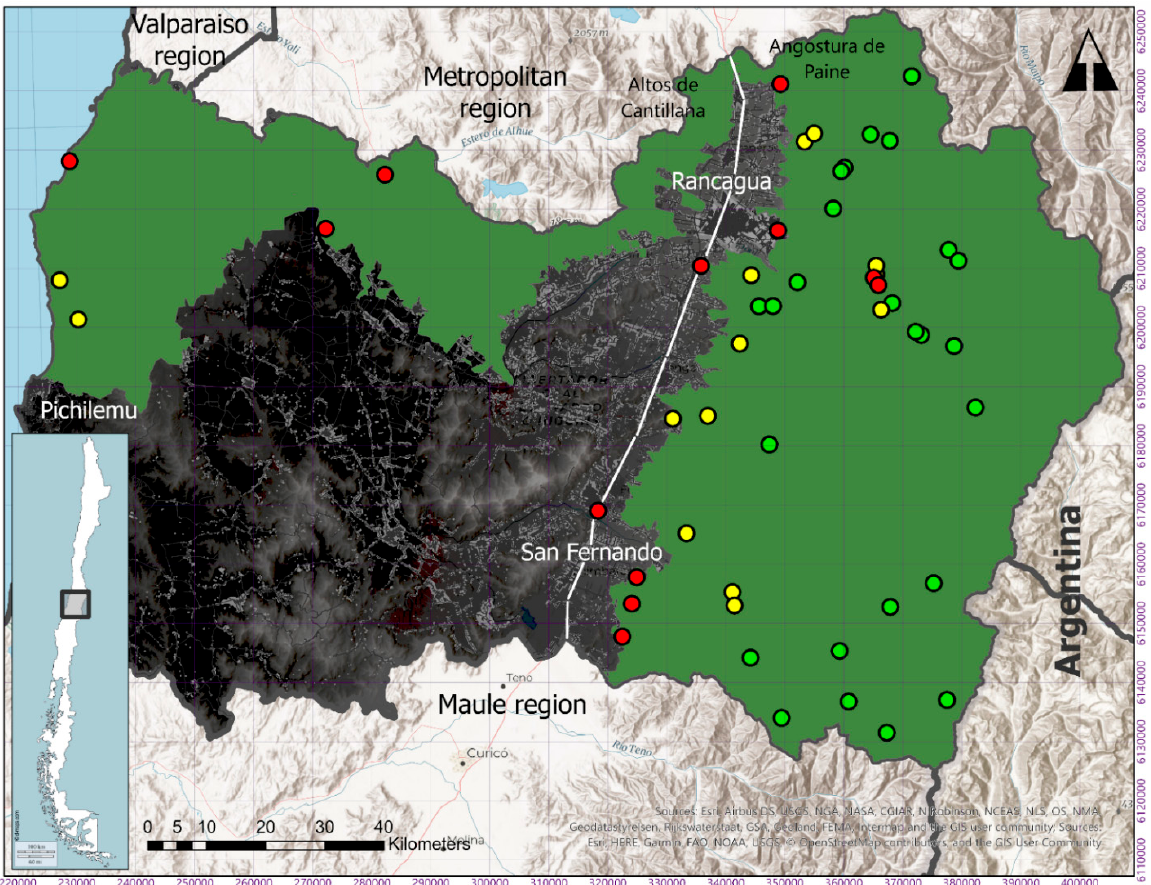
Figure 5. Suitable habitat for P. concolor movements across the region and most probable corridor between eastern and western areas. An area of approximately 9000 km 2 of suitable habitat was estimated (in green). The mountains of Angostura de Paine and Altos de Cantillana were identified as the most probable corridor for east-west puma movements. White line represents the main Chilean north-south highway (Ruta 5 Sur). Map scale 1—700,000.